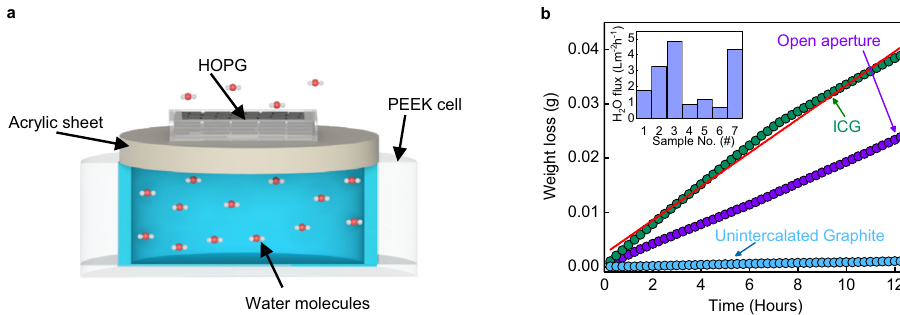
Fig. 3 Water permeation through intercalated graphite. a Schematic of our water evaporation setup. b Weight-loss through graphite samples is monitored as a function of time, which is a measure of the water evaporation rate. The area of the sample is 3.4 mm 2 . Over a span of 12 h, the measured weight-loss was little for the unintercalated graphite sample, whereas the intercalated graphite sample shows weight loss more than an open aperture. The solid red line is the best fi t to the measured data. Inset: water evaporation fl ux measured from seven such samples of